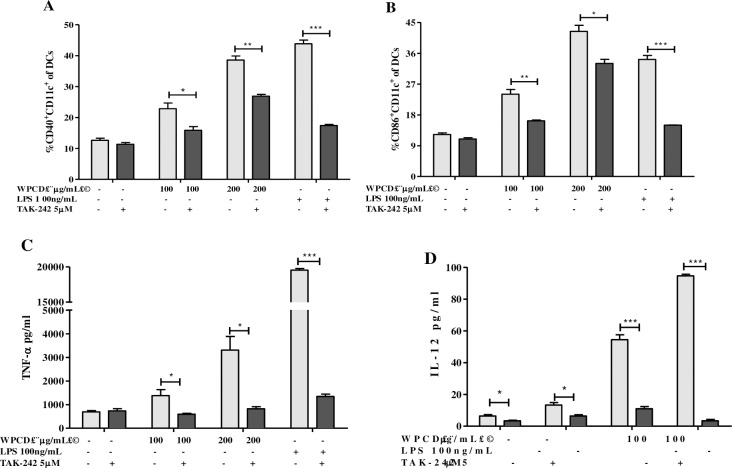
Effects of WPCD on BM-DCs function through TLR4-mediated pathway.After pretreatment with 5 μM of TAK-242 for 1 h, BM-DCs were treated with 100 ng/mL LPS or 100 and 200 μg/mL WPCD for 12 h in the presence or absence of Golgi Stop. Then CD40, CD86, TNF-a and IL-12 expressions were detected by FACs or ELISA. The MFI values of CD40 (A) and CD86 (B), the yields of TNF-a (C), and IL-12 (D) were shown. Data represent mean ± SD (n = 3) from 3 independent experiments.*P < 0.05, **P < 0.01, ***P < 0.001 compared with the untreated DCs group.